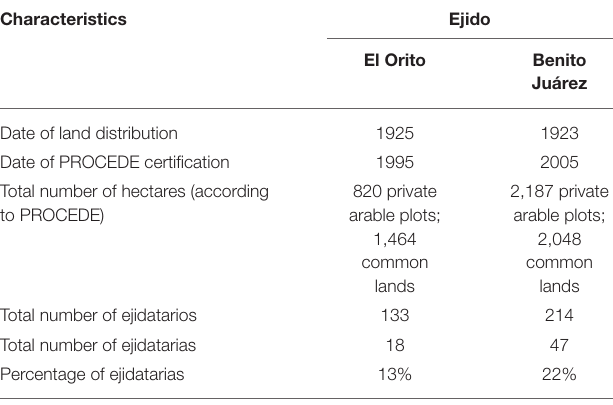
TABLE 1 | Characteristics of El Orito and Benito Juárez.